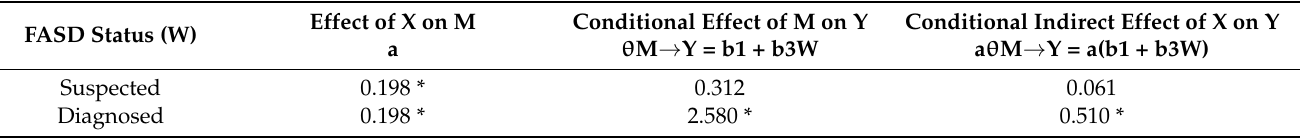
Table 4. Showing the conditional indirect effects of regulation and FASD diagnostic state on the relationship between ADHD-C and rewards.